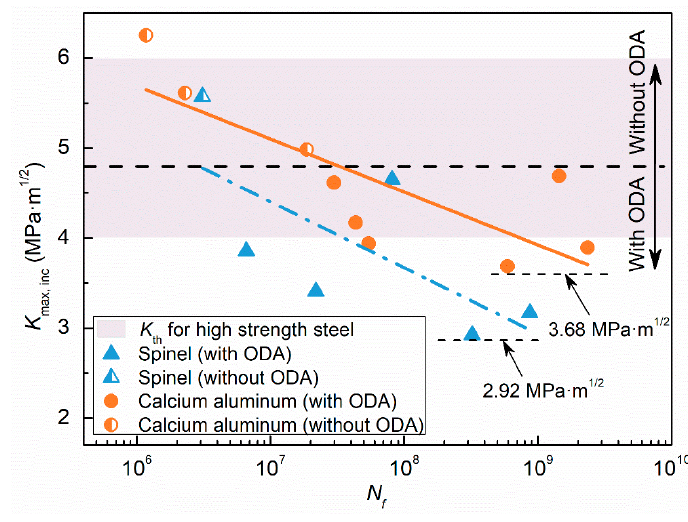
Figure 10. K max,inc for spinel inclusions and calcium aluminate inclusions.